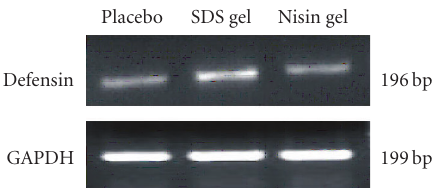
Figure 11: RT-PCR analysis of defensin-1 gene in CVE cells of rabbit. No change was seen in defensin-1 gene expression between nisin gel and placebo gel administered groups. However, significant activation of defensin-1 gene expression was observed in SDS gel administered group compared to placebo and nisin gel treated